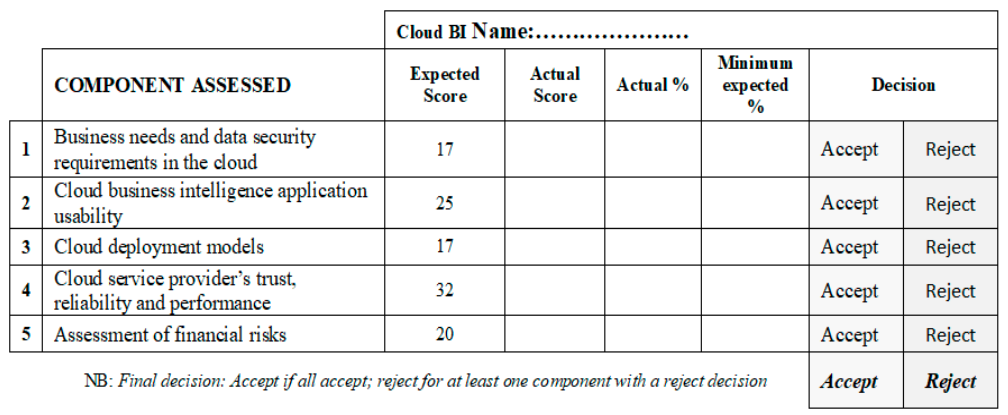
Figure 13. A summary sheet for each set of evaluations.